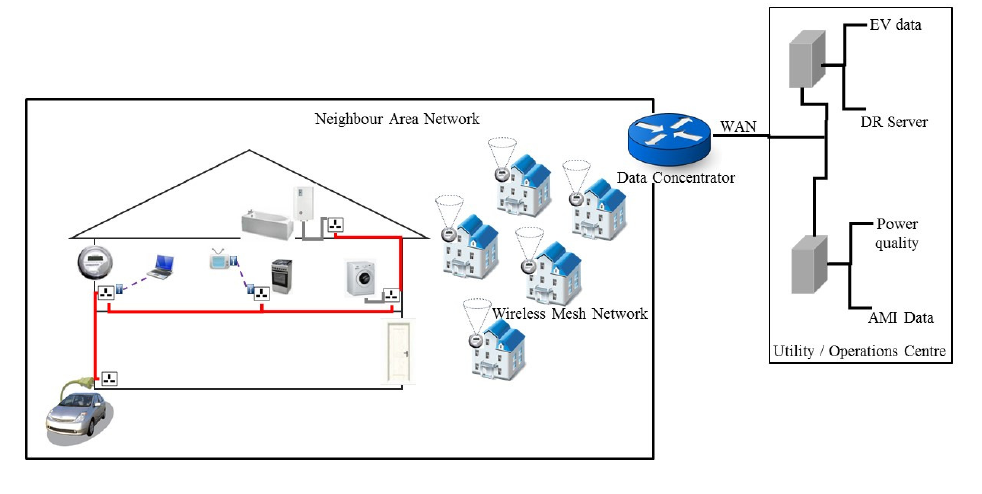
Figure 4. Simulation scenario of a WMN-based NAN in